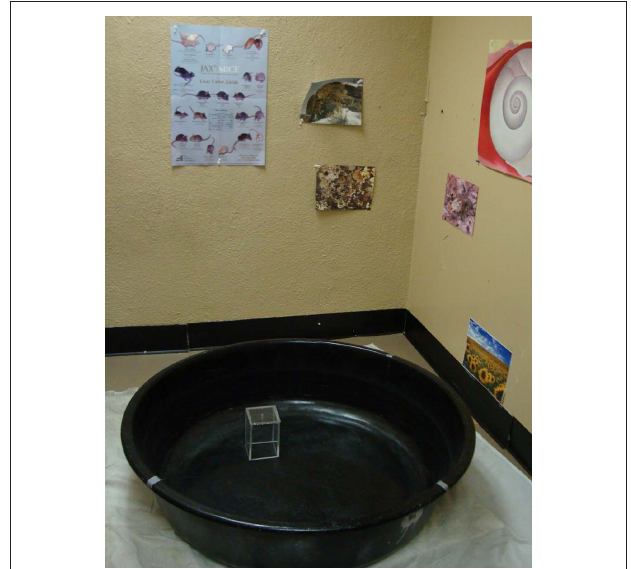
Figure 1 | The MWM is a test of spatial learning and memory. Through successive placements into the pool of water, the animal learns to swim to the location of the platform with the aid of distal, extra-maze cues placed around the apparatus. A cued condition where the hidden platform is made visible serves as a control for sensory or